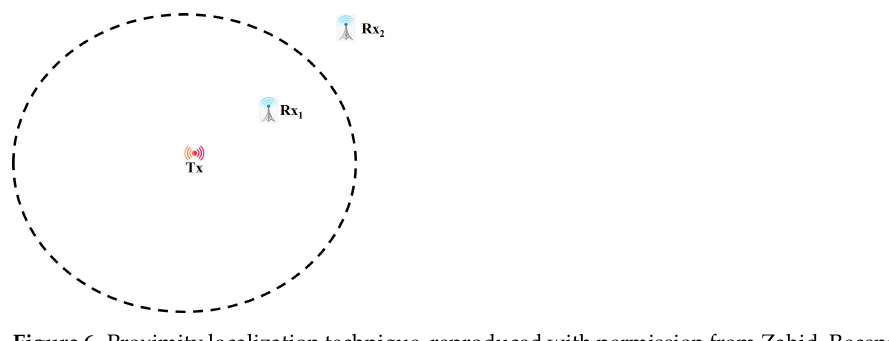
Figure 6. Proximity localization technique, reproduced with permission from Zahid, Recent Advances in Wireless Indoor Localization Techniques and System; published by Hindawi Limited,